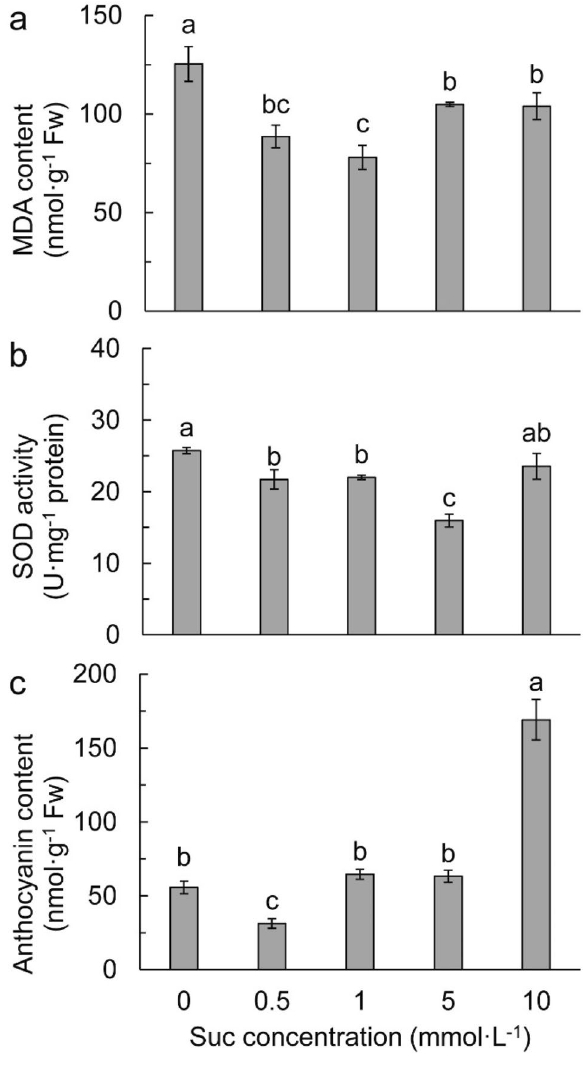
Figure 2. Leaf MDA content ( a ), SOD activity ( b ) and anthocyanin content ( c ) in different sucrose concentrations. Data refers to means ± SE ( n = 4). Bars with the same letter are no statistically significantly difference at P < 0.05 by Duncan’s new multiple range